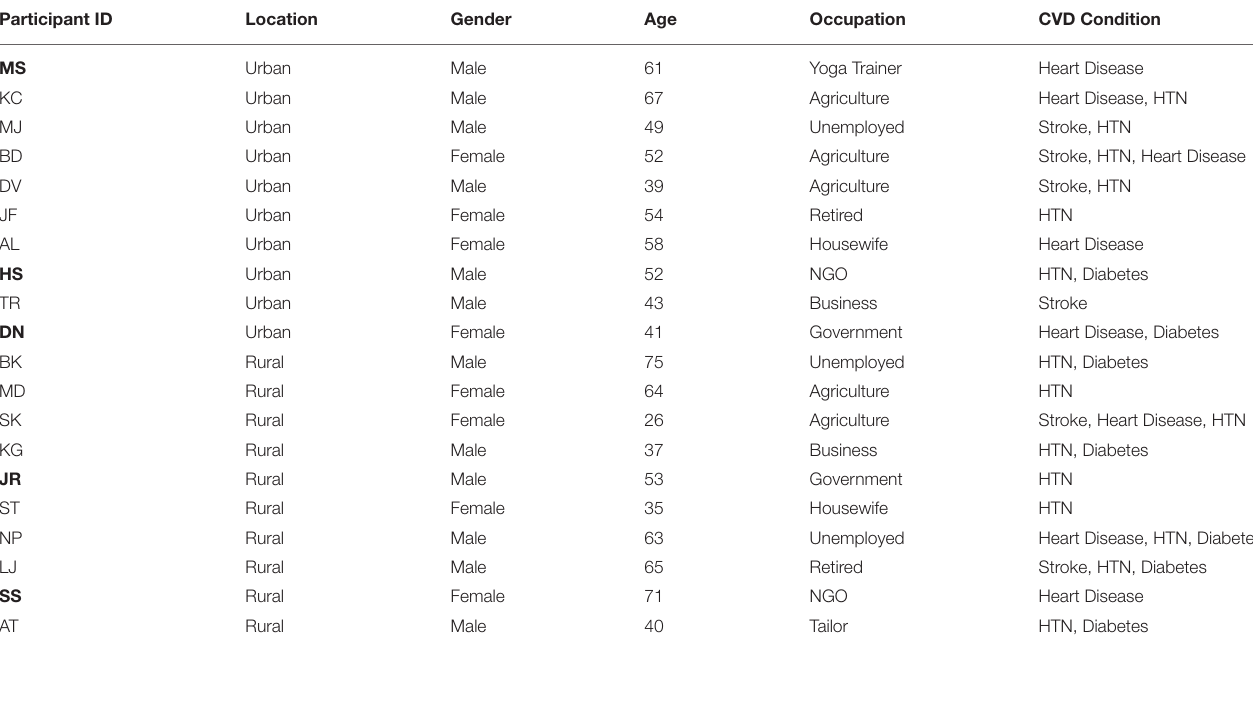
TABLE A1 | Sociodemographic Profile of In-Depth Interview